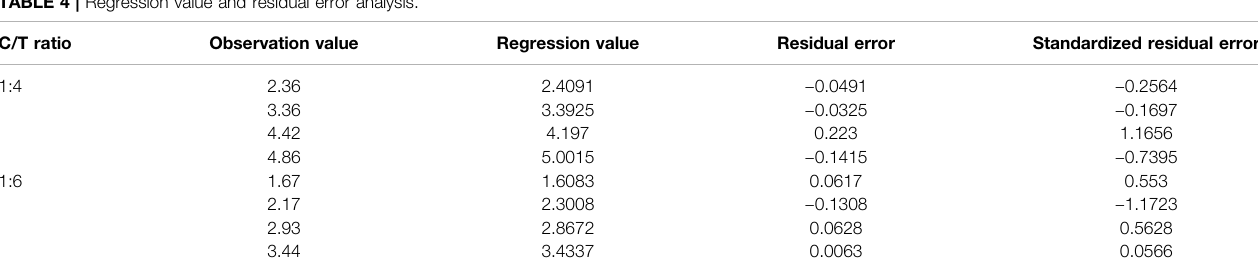
TABLE 4 | Regression value and residual error analysis.